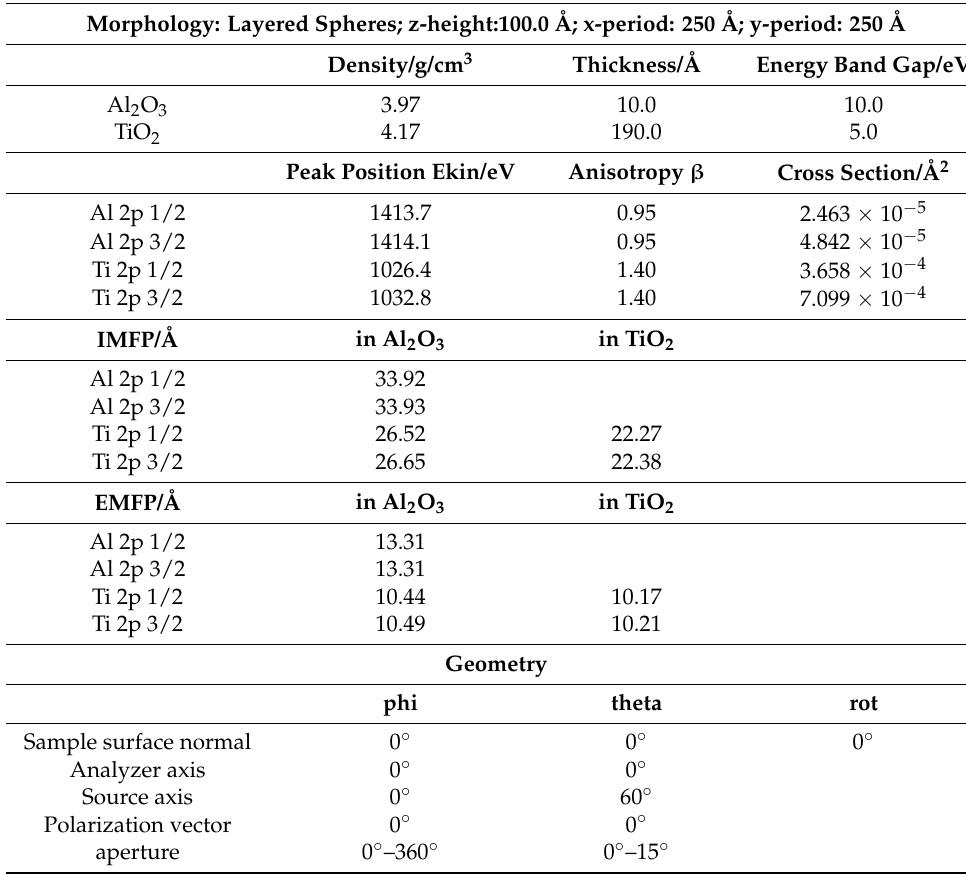
Table A2. Input parameters for SESSA and mean free paths (IMFP: inelastic mean free path; EMFP: elastic mean free path).